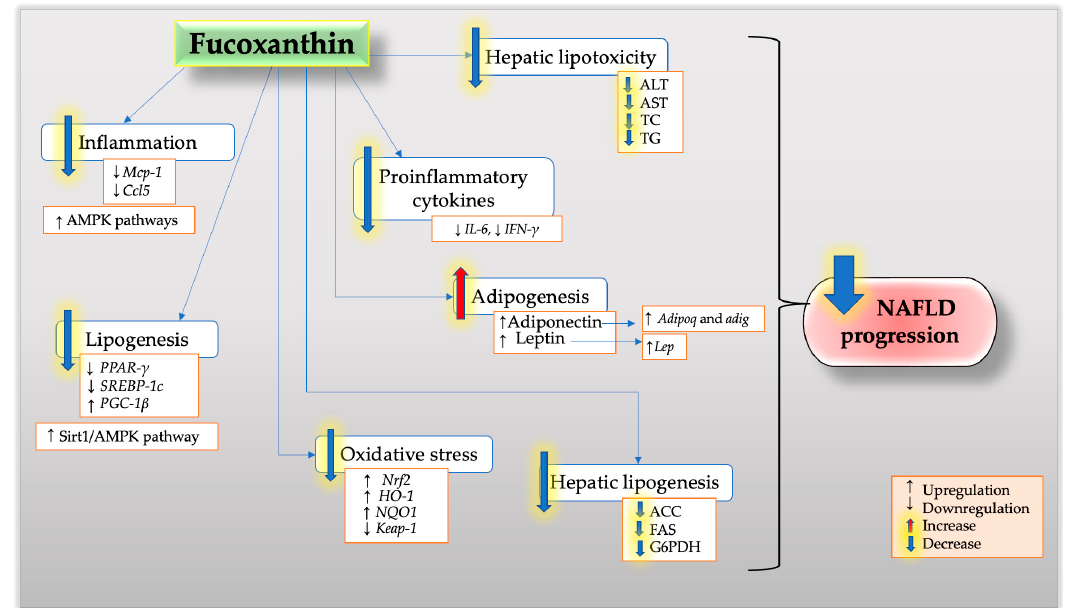
Figure 1. The potential effects and mechanisms of fucoxanthin on NAFLD.